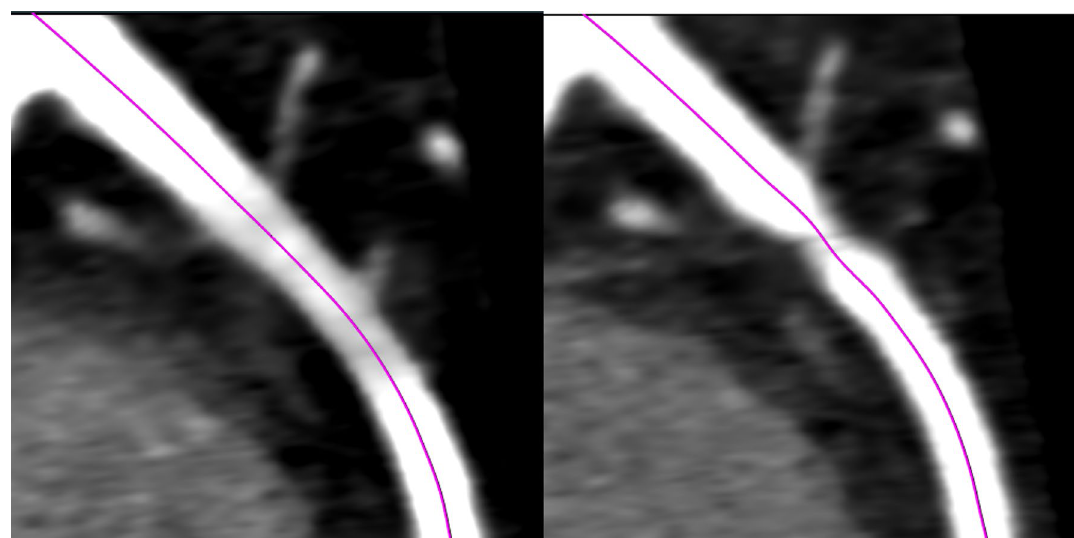
Figure 4. Curved Planar Reformatted (CPR) view of the Right Coronary Ascending (RCA) proximal segment for a reconstruction with mixed stacking (left) and true stacking (right) of the same raw data set. Due to the sharp slab boundaries the visual perception suggests a narrowing of the